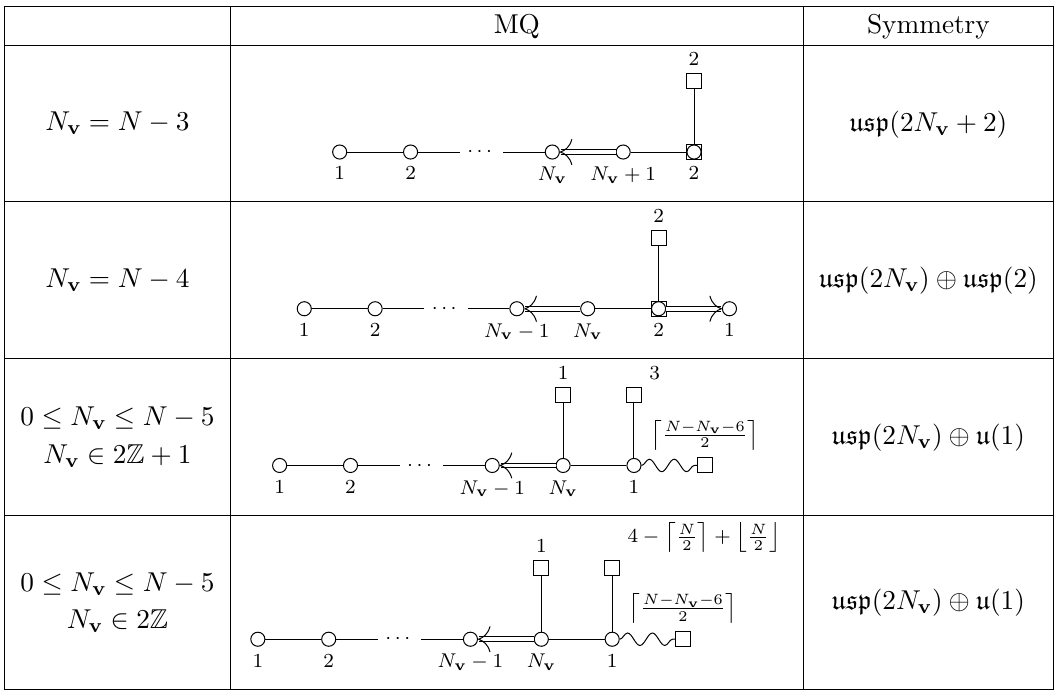
Table 1 . Magnetic quivers for the infinite gauge coupling limit of 5d SO ( N ) gauge theory with N v hypermultiplets transforming in the vector representation of SO ( N ) . The reader is referred to section 2 for the notation we use in the